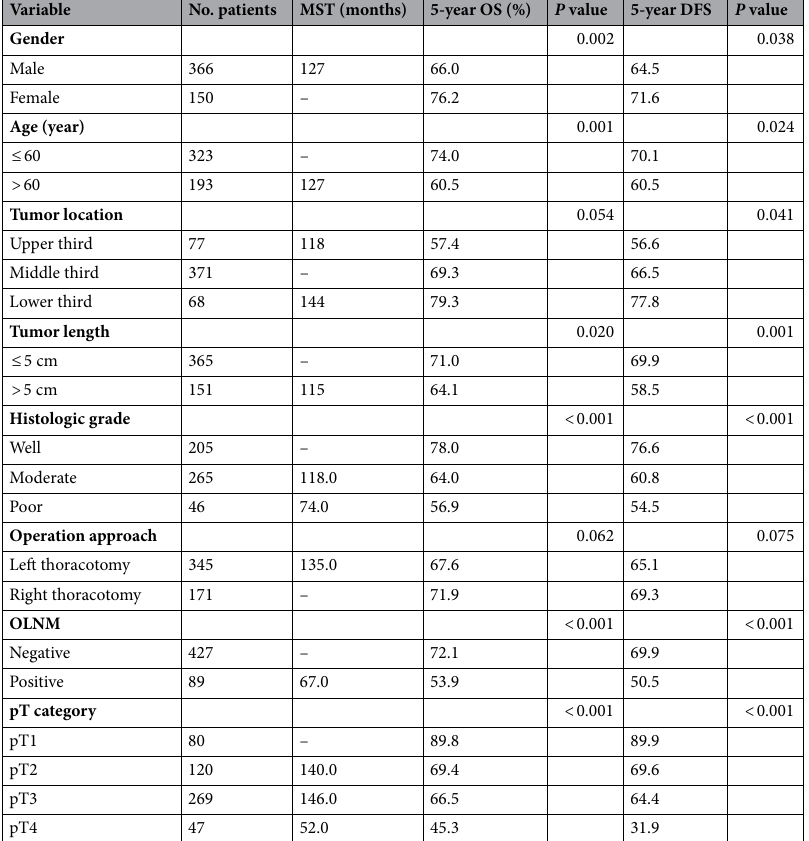
Table 2. Univariate analysis in regard to overall survival and disease-free survival according to patient and tumor characteristics. DFS disease-free survival, MST median survival time, OS overall survival, OLNM occult lymph node